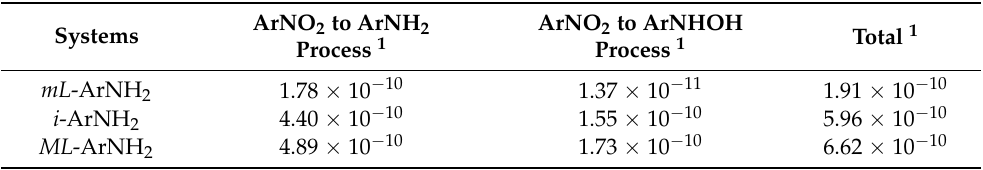
Table 1. Surface covering calculated from the voltametric response of nitrophenyl groups for modified